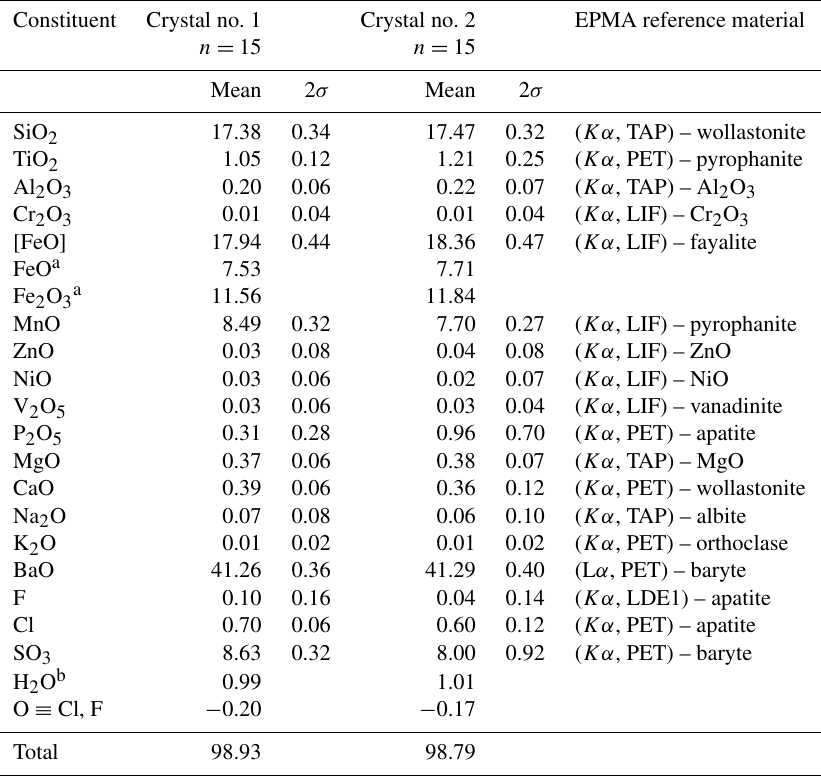
Table 2. Chemical data (in wt%) for